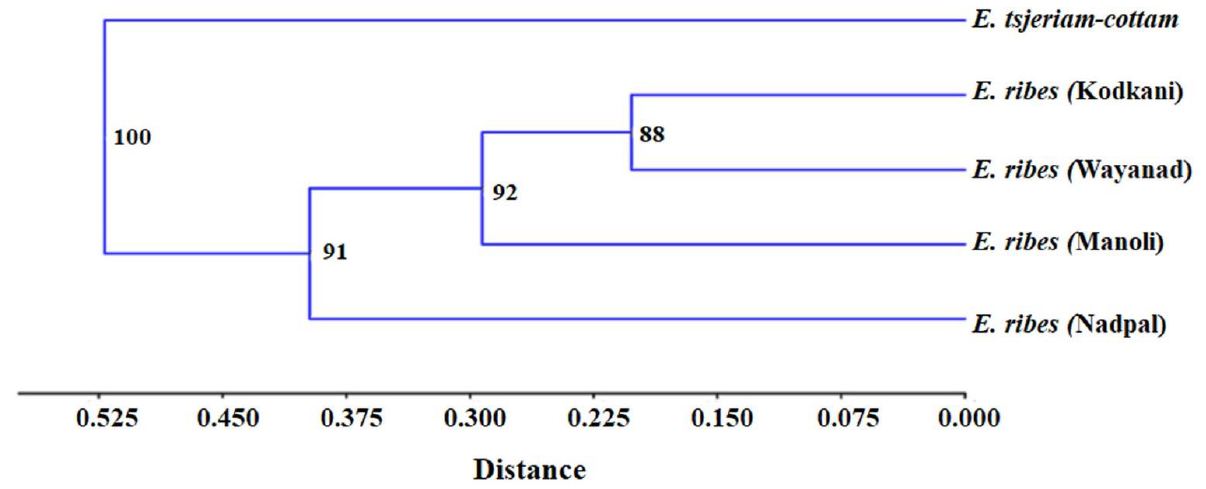
Figure 5. Genotypic diversity among Embelia ribes accessions from different geographical re- gions. After scoring the amplified products on Embelia and E. tsjeriam-cottam by nine IISR primers, obtained binary data was used to generate a phylogenetic tree. E. tsjeriam-cottam was used as an outgroup. Wayanad and Kodkani accession share the same clade, whereas the Manoli accession connects the Nadpal accession with Wayanad and Kodkani accessions. The outgroup is forming a separate clade. The scale at the bottom of the phylogenetic tree quantifies the Jaccard distance be- tween the genotypes. Numbers at each tree node indicate the bootstrap value of the respective clus- ter computed at the 1000 bootstrapping threshold.